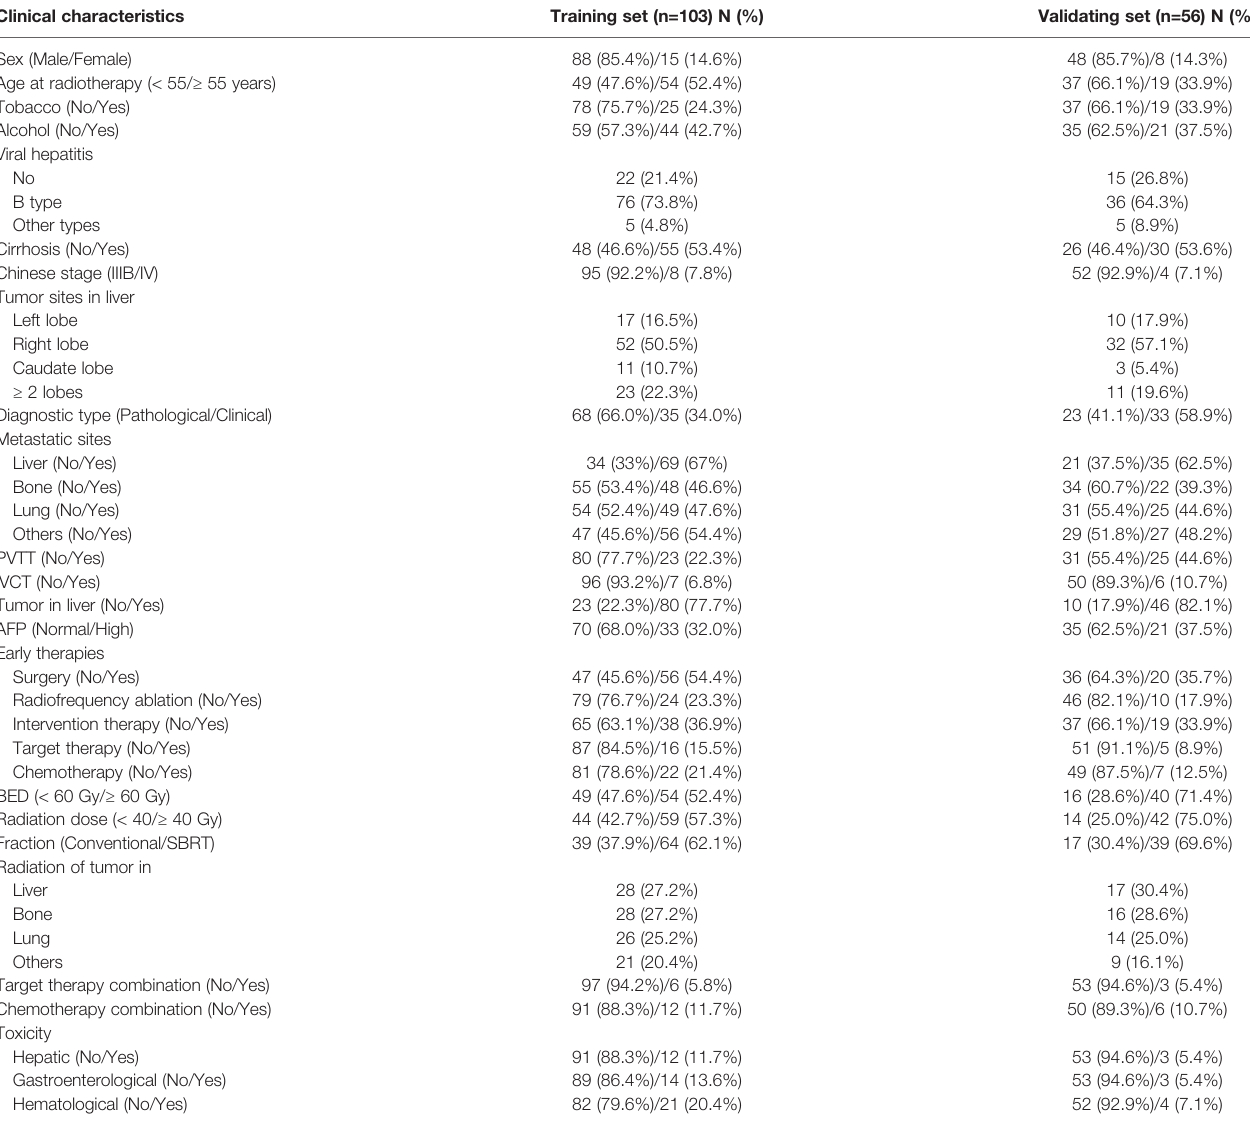
TABLE 1 | Clinical characteristics of patients. Clinical